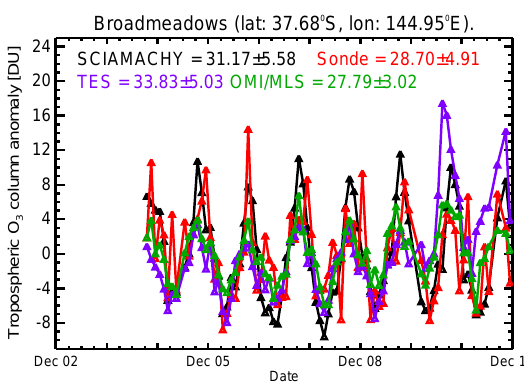
Figure 11. As Fig. 6, but over Macquarie Island (54.50 ◦ S, 158.95 ◦